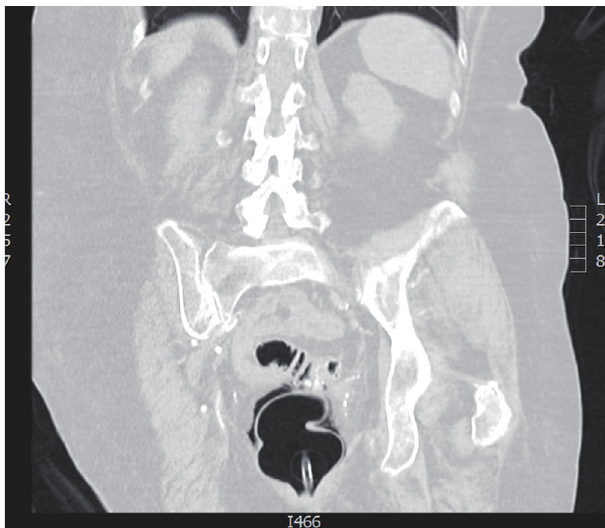
Figure 2. CT colonography coronal view depicting rectal perforation. The Foley catheter is seen within the rectum as well as peri-rectal air.